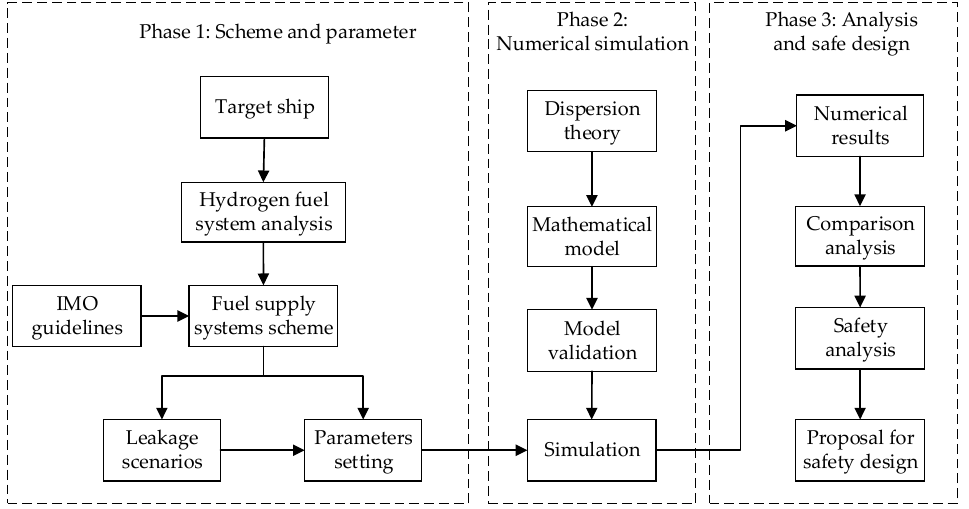
Figure 2. Framework of this study.